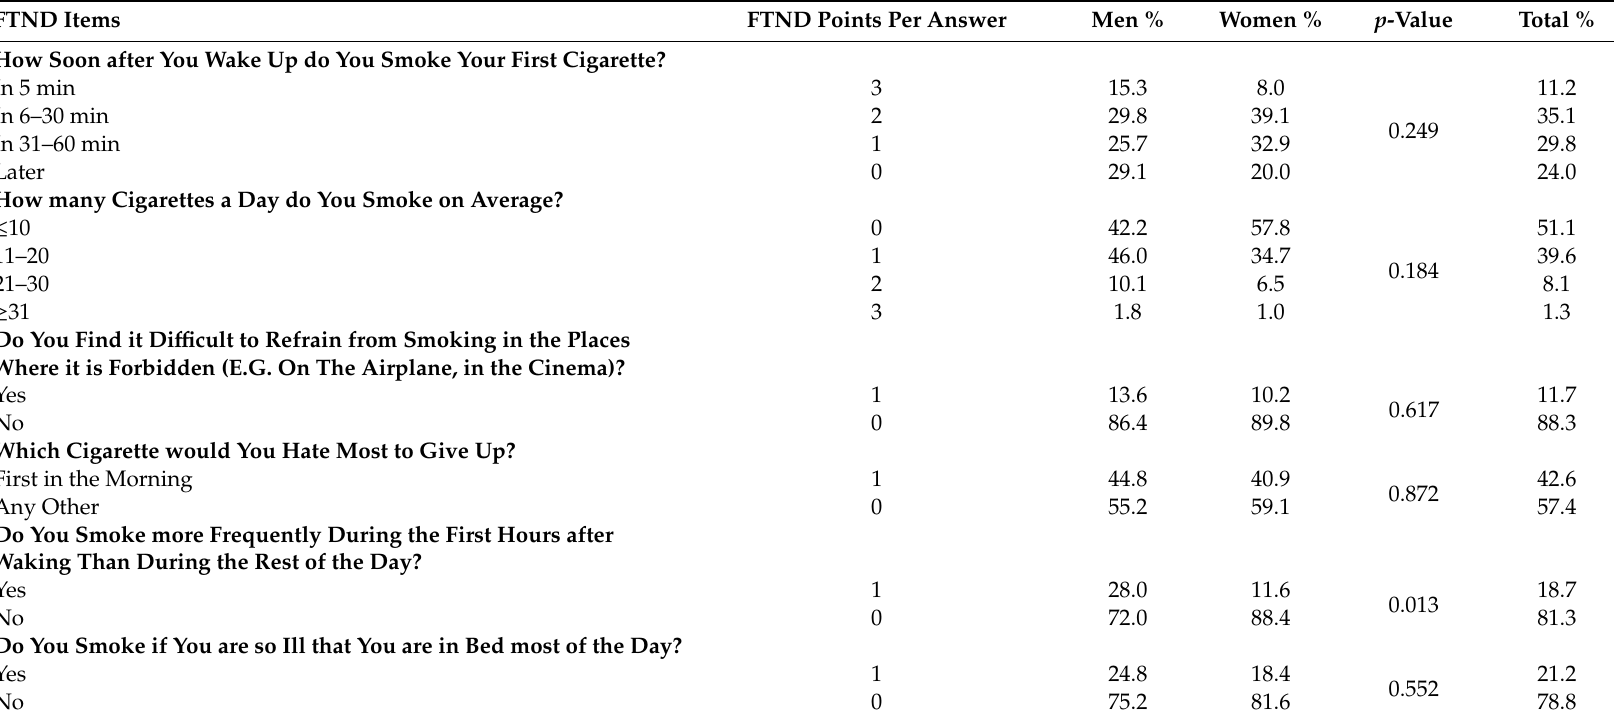
Table 2. Distribution (%) of the results of the six-item Fagerström Test for Nicotine Dependence (FTND) with points for calculation of nicotine dependence (ND) score among Estonian physicians,